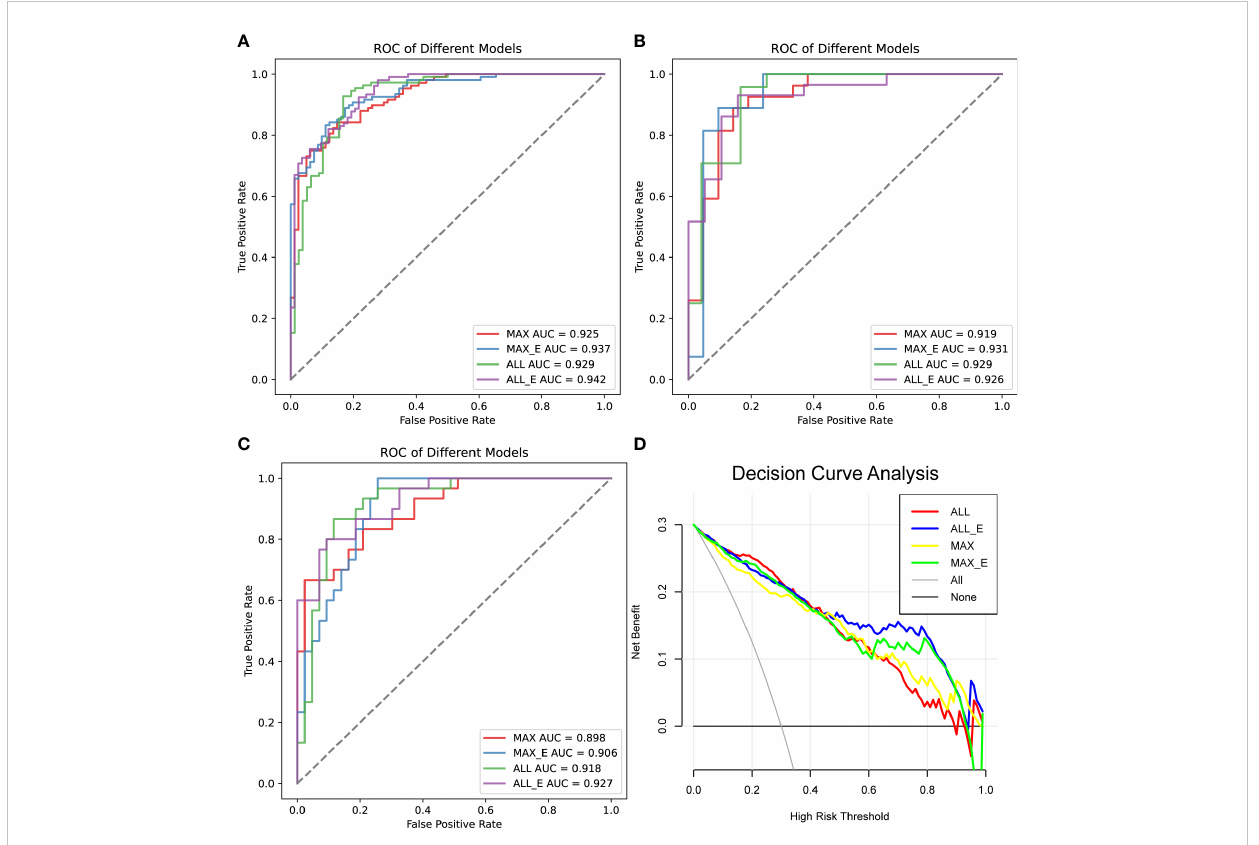
FIGURE 4 Comparison of the diagnostic performance of the four radiomics models. (A) ROC analysis of the training set, (B) ROC analysis of the internal test set, and (C) ROC analysis of the external validation set. (D) Decision curve analysis, the net bene fi t rate of ALL_E model with High Risk Threshold between 0.5 and 0.8 was the highest. AUC is the area under the